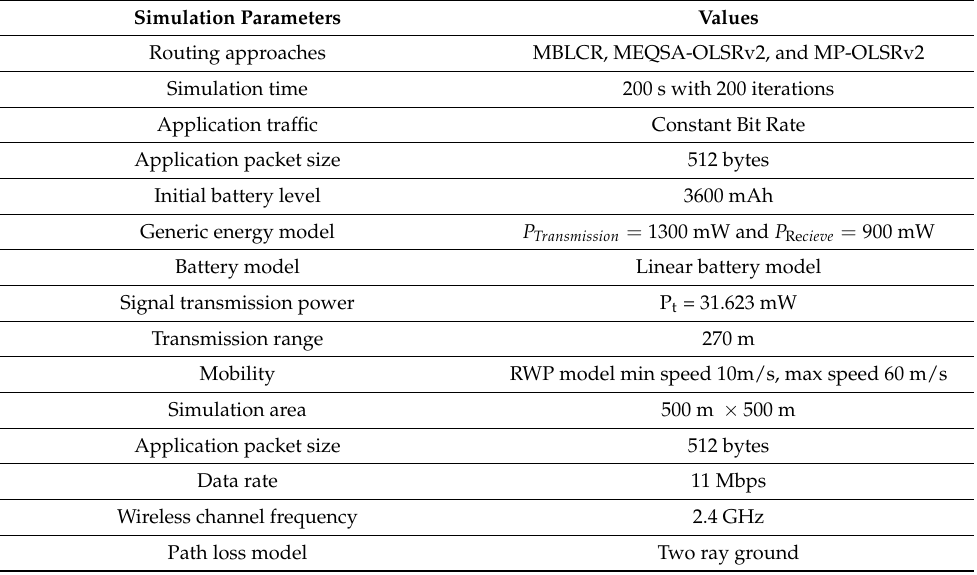
Table 1. Simulation parameter values. Simulation Parameters